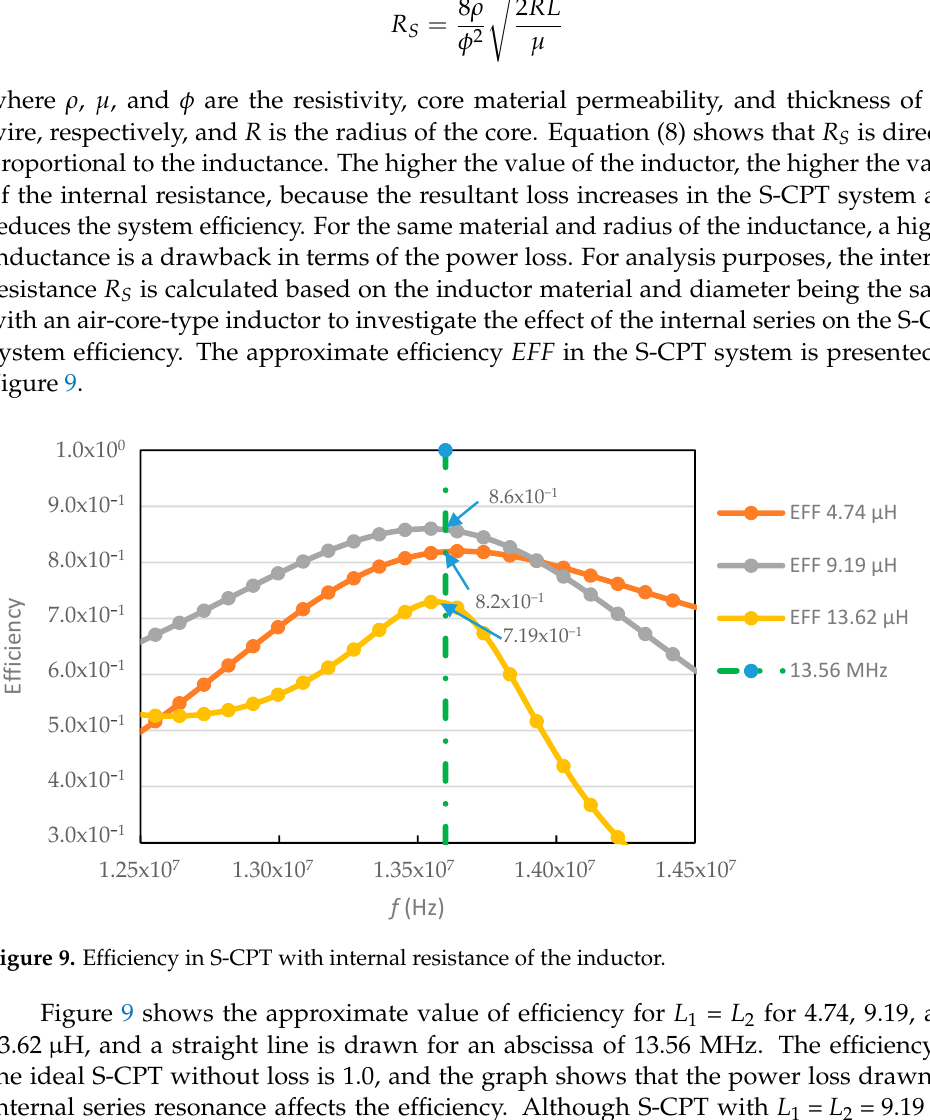
Table 2. Findings for the symmetric S-CPT based on the analysis method.